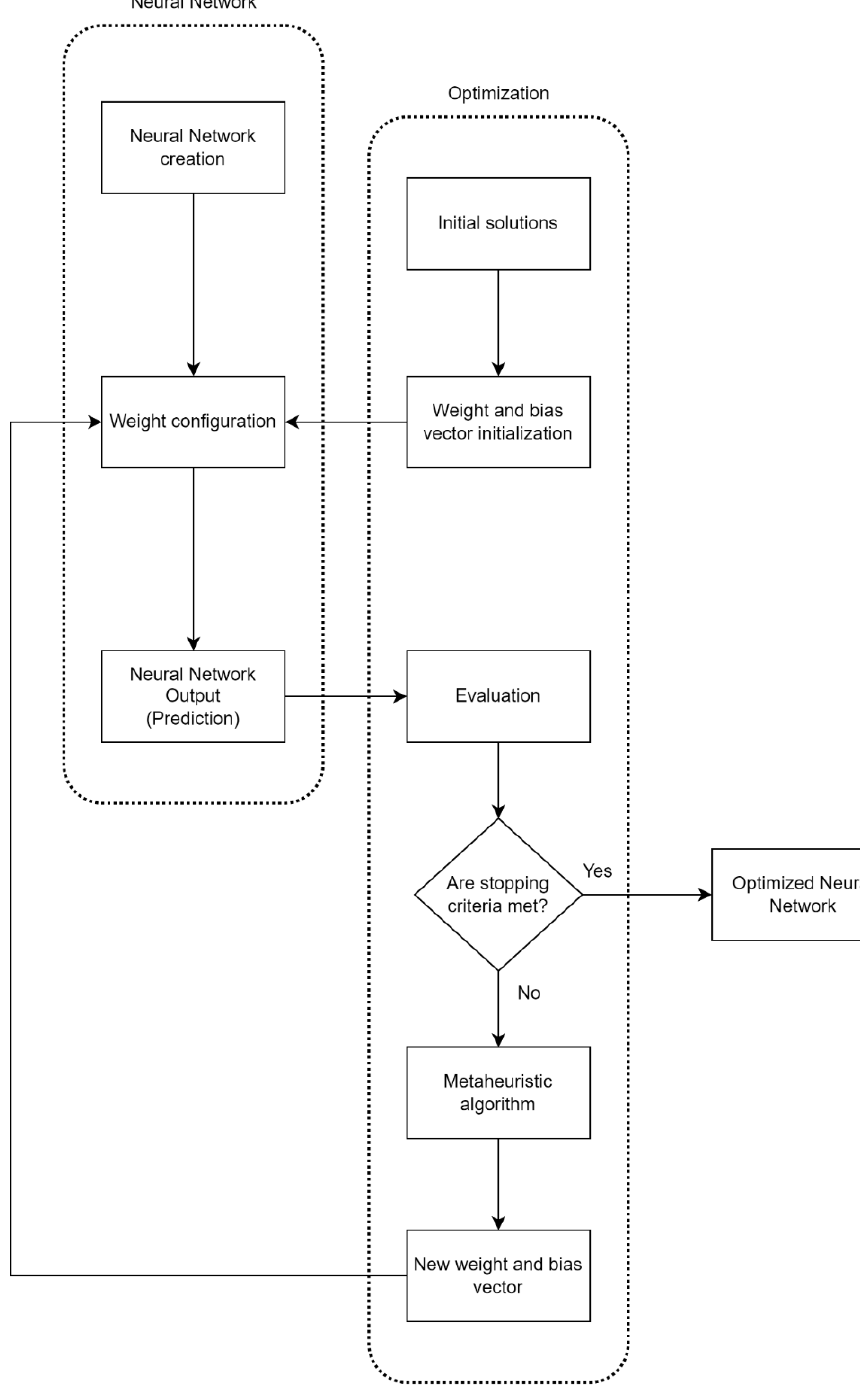
Figure 2. ANN ’ s training using a metaheuristic algorithm. Figure 2. ANN’s training using a metaheuristic